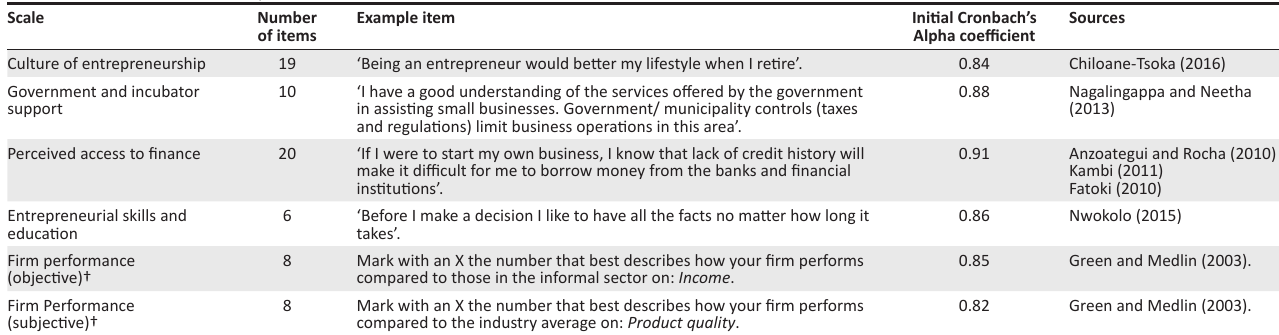
TABLE 1: Scales used for the study.